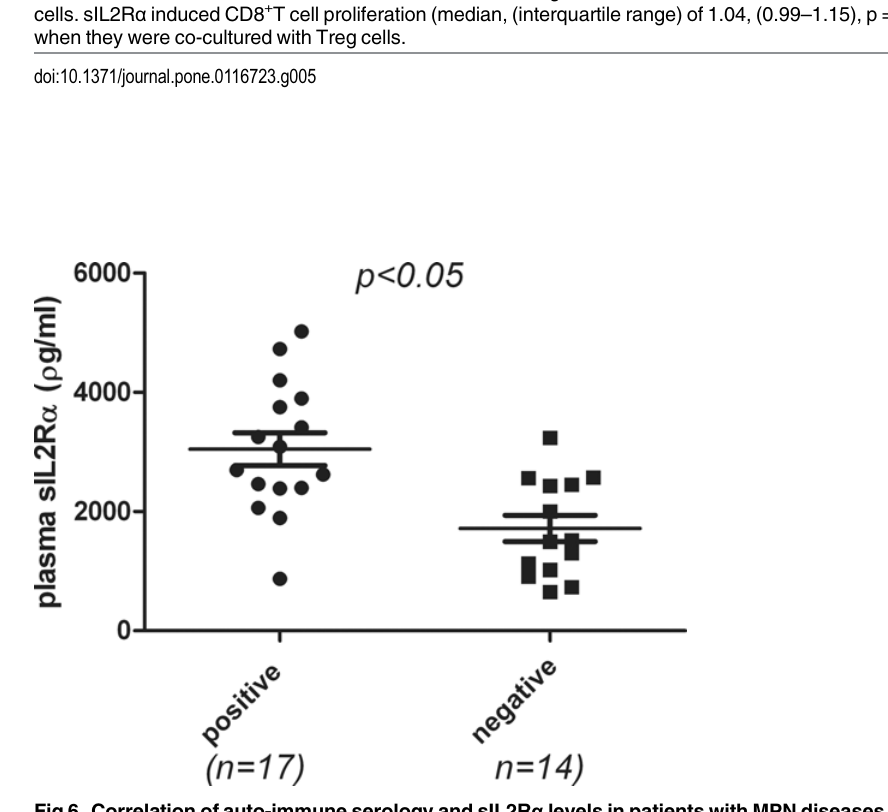
Fig 6. Correlation of auto-immune serology and sIL2R α levels in patients with MPN diseases. Auto- immune serology panels were performed as outlined in the materials and methods. 31 patients including PMF (9) ET-MF(1) PV-MF(4), ET(8), PV(9) were studied. Patients with at least one positive serology have significantly elevated sIL2R α levels compared to negative patients (p < 0.05)